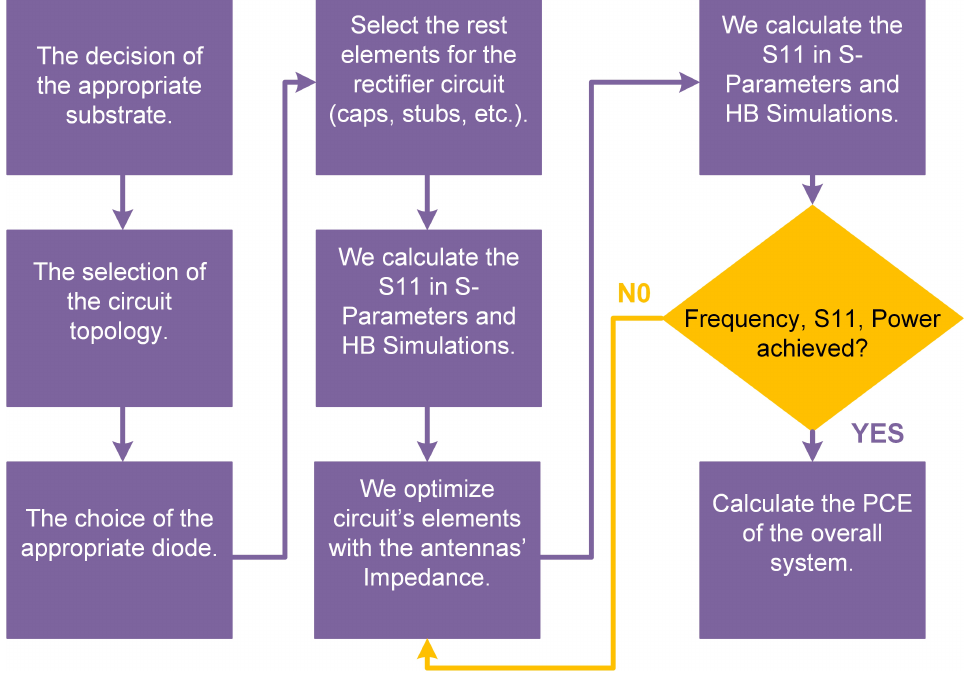
Figure 2. Design